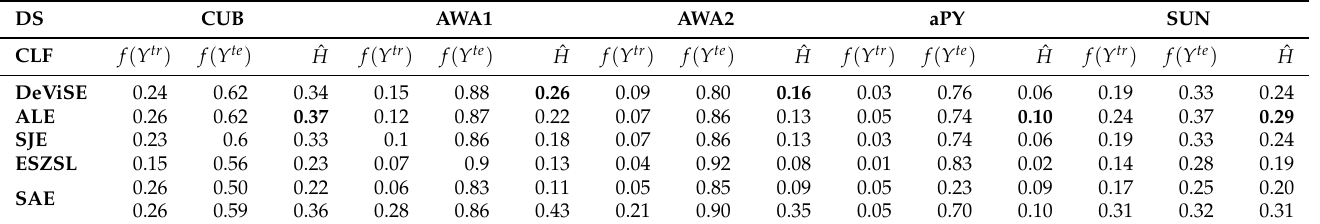
Table 7. Individual Classifier Results for the F1